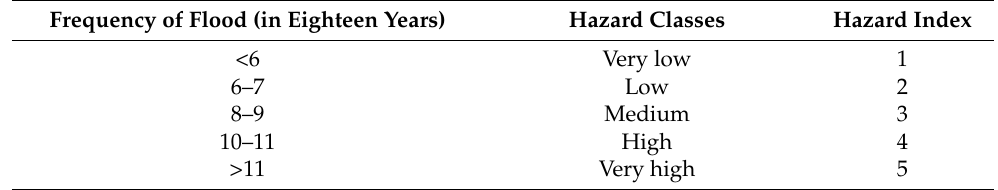
Table 1. Flood hazard index.